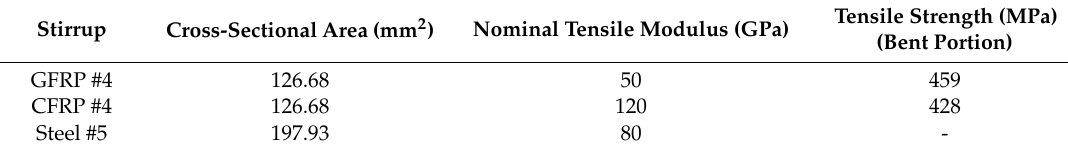
Figure 3. Reinforcement details of BS1 and BS2 (all the dimensions are in mm). Table 4. Mechanical properties of shear